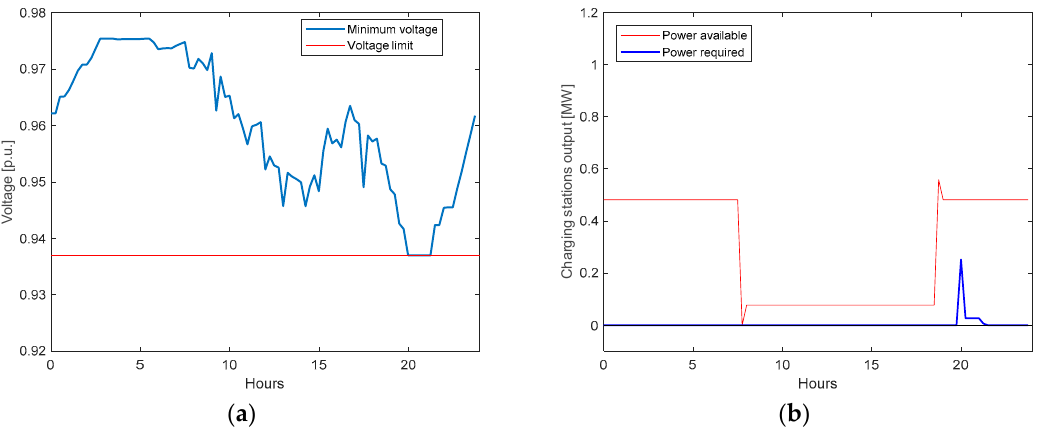
Figure 7. Profile of the minimum voltage in the whole network ( a ); power injected by the EVs home station to contain the voltage violation ( b ).